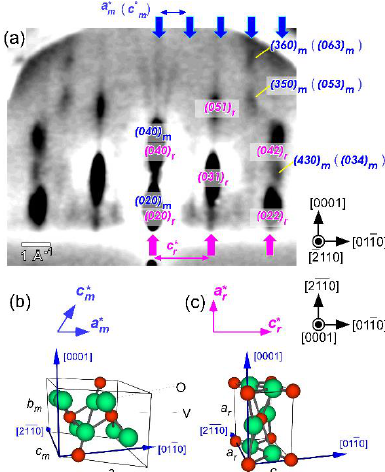
Figure 3. ( a ) Typical reflection high-energy electron diffraction (RHEED) pattern of VO 2 film observed at 70 °C. The incident electron beam direction was [2̅110] 𝐴𝑙 2 𝑂 3 . The spots indicated by blue and pink reflections (and arrows) correspond to the monoclinic and rutile VO 2 phases, respectively. Schematic two-dimensional (2D) reciprocal lattice unit vectors on (0001) 𝐴𝑙 2 𝑂 3 (top panel) and real-space crystal structures (bottom panel) for ( b ) monoclinic and ( c ) rutile VO 2 phases. The crystalline orientation relationships of monoclinic and rutile VO 2 (010) to Al 2 O 3 (0001) are visualized with blue arrows representing Al 2 O 3 [011̅0], [2̅110], and [0001] .